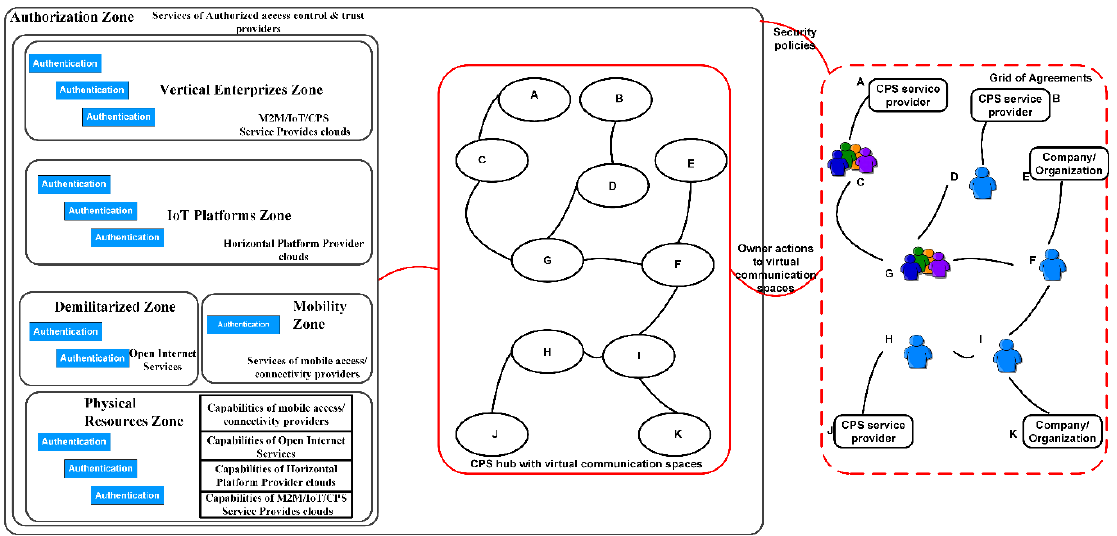
Figure 2. Conceptual model of trustworthy communication hub for cyber-physical systems.